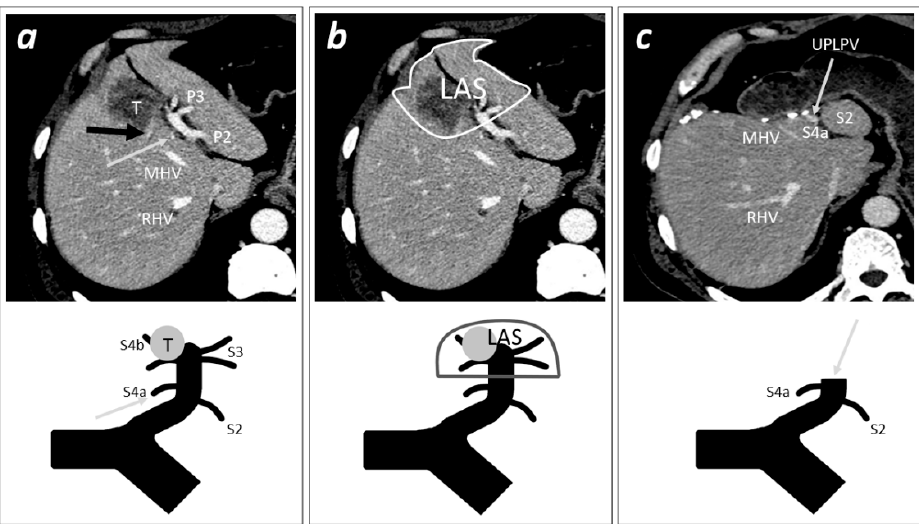
Figure 2. A case of tumor invading the distal part of the UPLPV treated with Left Anterior Sec- torectomy. The careful pre-operative evaluation of CT-scan is fundamental to identify the pattern of LPV’s branching, to ascertain the presence of LAS, and to indicate the surgical procedure of left anterior sectorectomy. Each picture (“a”, ”b”, and “c”) includes a CT-scan imaging (above) and a schematic illustration of the portal skeleton (below) of the pre- or post-operative hepatic portal anatomy of a patient with a tumor invading the distal part of the UPLPV and the right horn of the LPV. ( a ) (Pre-operative) the CT-scan shows a portal pedicle represented by one branch for S2